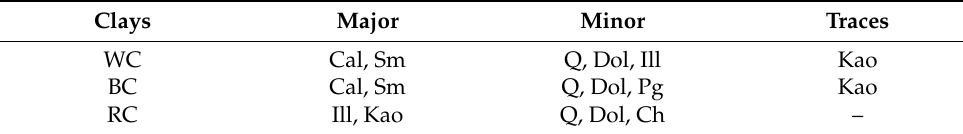
Table 4. Mineralogy composition of the clays under